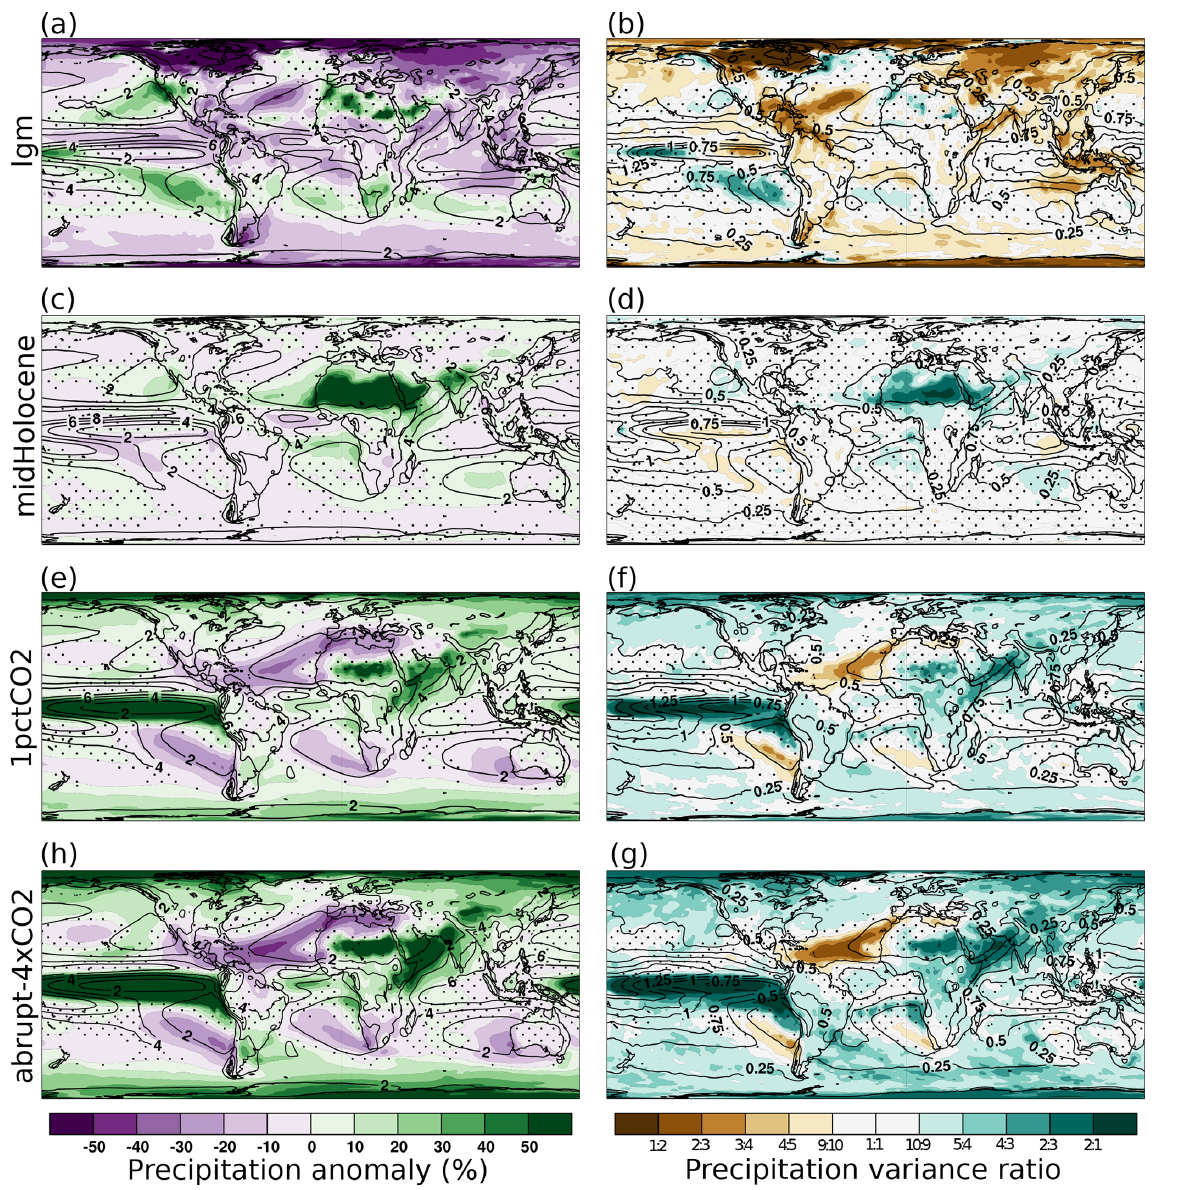
Figure 3. The change in mean annual precipitation (a–d) and its variability (e, f) across multiple climate experiments. Each panel shows the ensemble average difference (as percentage changes with respect to each model’s piControl). The changes in variability are based on the ratio of the standard deviation of annual mean precipitation in the experiment to that of the piControl experiment. Ratios above 1 indicate higher variability in the experiment than in the piControl. The contours in each panel show the ensemble mean pattern in the preindustrial control (mmd − 1 ). Contour variations are due to the different number of models available for individual experiments, as the preindustrial ensemble mean is only computed from models in each experiment. Stippling indicates where the sign of the change disagrees for more than two-thirds of the